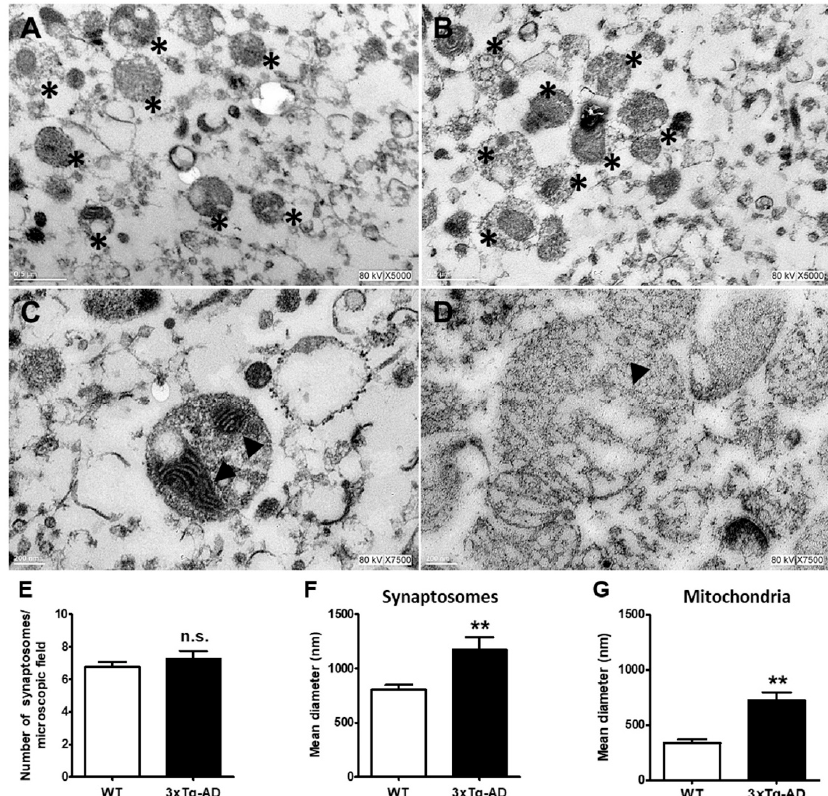
Figure 4. Ultrastructural changes in middle-aged hippocampal synaptosomes. Representative electron microscopy images of synaptosomes (*) from WT ( A ) and 3xT-AD mice ( B ). Changes in synaptic and mitochondria size in WT ( C ) and 3xTg-AD mice ( D ) are depicted. Mitochondria are marked with arrowheads. Bars represent the mean ± SEM of 3–4 synaptosomal random sections from each experimental condition from 3 independent experiments. Synaptosomes number ( E ), synaptosome diameter ( F ), and mitochondrial diameter ( G ). Scale bar = 200 nm. Student’s t test, ** p < 0.01; n.s. = no statistically significant difference.